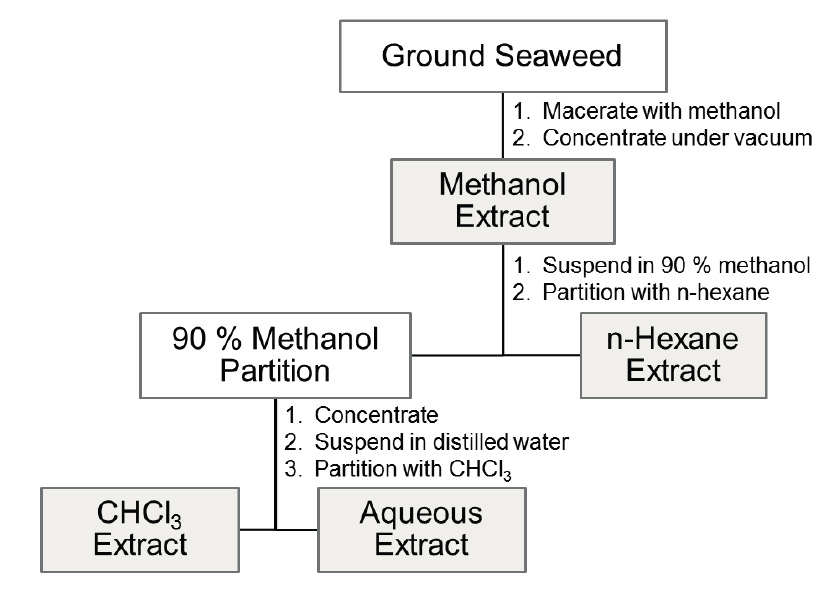
Figure 4. Procedure for preparing extracts representing a range of polarities. Source: Adapted from Jones and Kinghorn